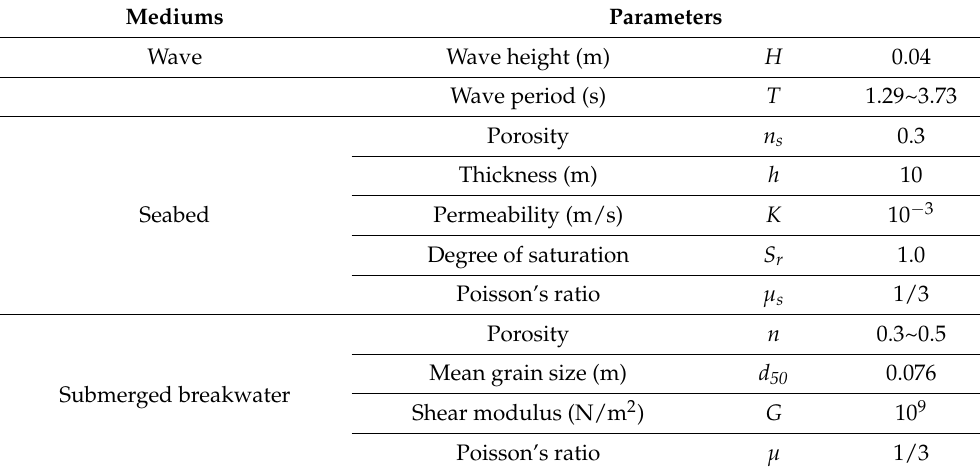
Figure 5. Schematic diagram for the wave trapping by the double/triple trapezoidal porous structures near a vertical wall (not to scale). Table 1. Test conditions of the numerical simulations.